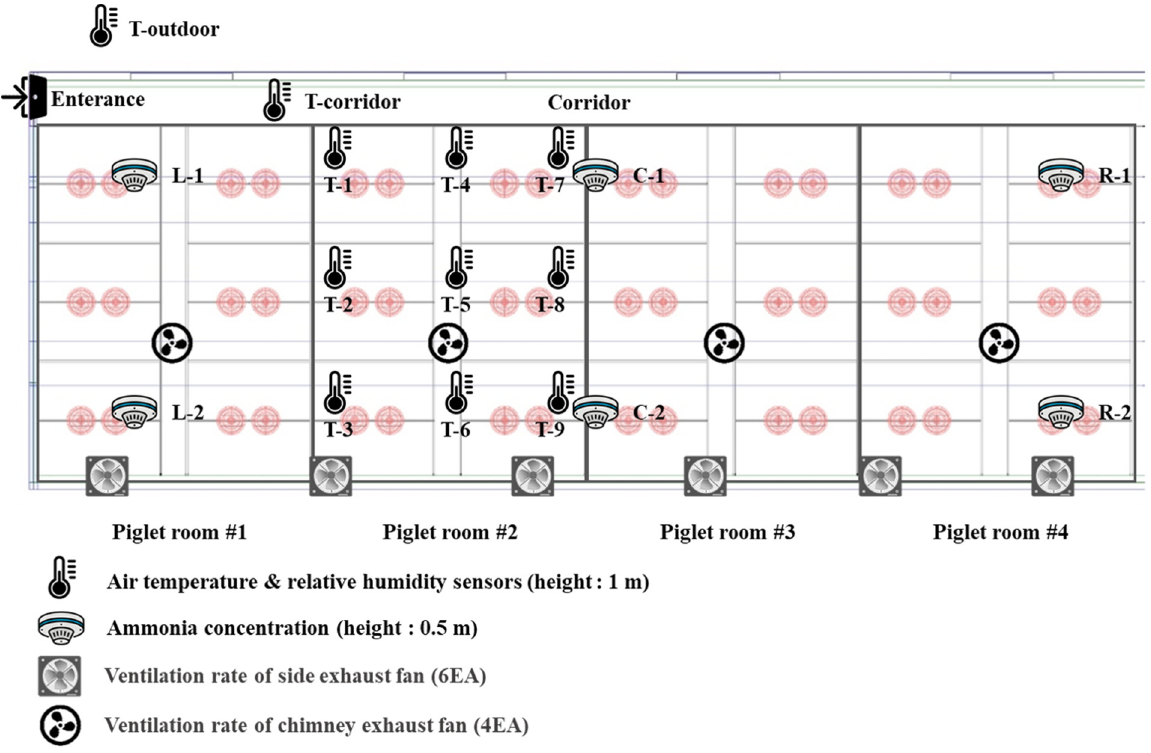
Figure 5. Installation location for each sensor inside the experimental pig